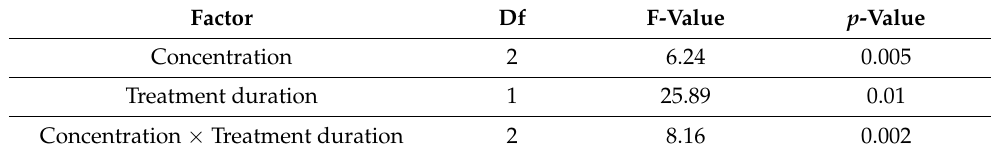
Table 1. Results of the MANOVA.